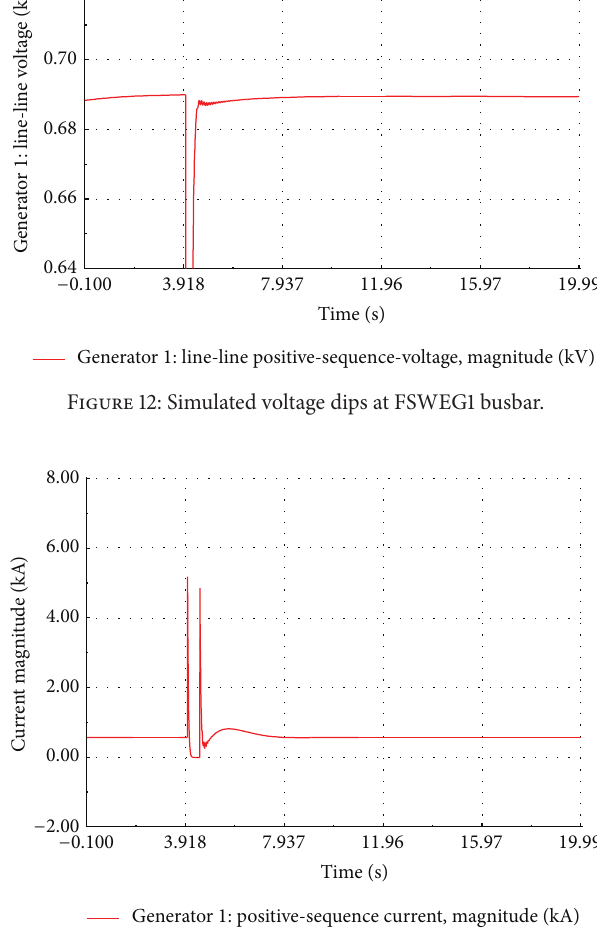
Figure 13: Simulated current of